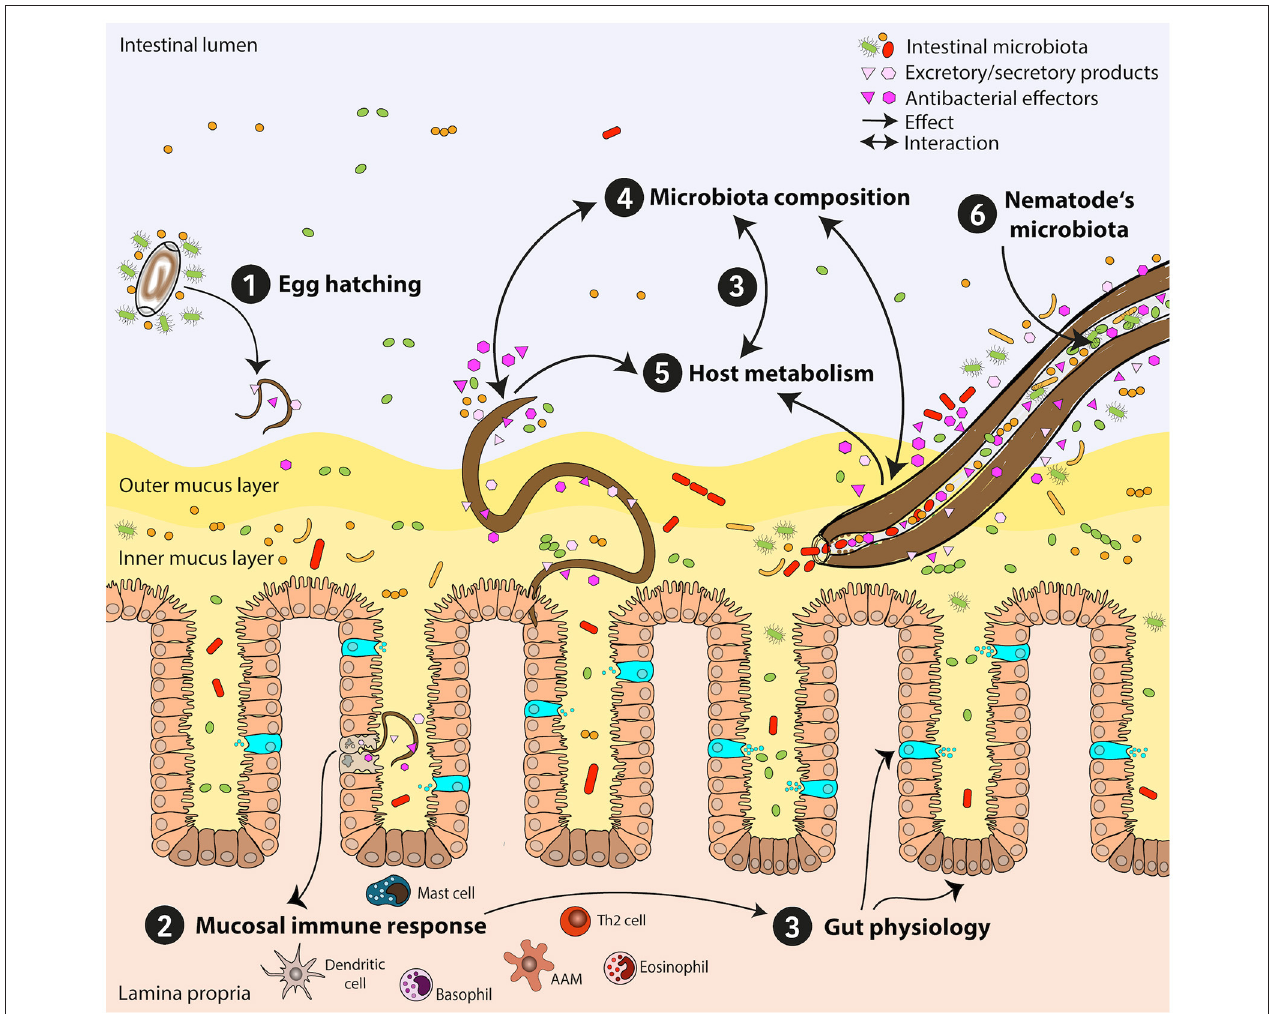
FIGURE 2 | Mutual influences of intestinal nematodes and host-gut bacteria. Establishment and persistence of intestinal nematodes in the host’s gut are affected by bacterial communities and lead to substantial changes of the gut microbiota. Here, nematode-microbiota interactions and their impact on the host immune response and physiology are exemplified. (1) Egg hatching: Interaction of eggs with the intestinal microbiota is needed for some species, enabling larvae to hatch. (2) Mucosal immune response: Attachment to the epithelium and tissue migratory phase might lead to bacterial translocation and manipulation of immune responses. The anti-helminth immune response is predominantly a T helper type 2 response. (3) Gut physiology: Immune responses induce changes in gut physiology via induction of goblet cell hyperplasia, mucus production, and epithelial turnover, leading to changes in the host microbiota and its metabolome. Specific subsets of bacteria directly influence host physiology through their metabolic activities (e.g., short chain fatty acids-producing bacteria). (4) Microbiota composition: Intestinal nematodes modify intestinal microbial communities via different mechanisms: a) directly via secretion of antibacterial molecules and/or excretory/secretory products, b) indirectly by metabolic and physiologic shifts influencing the gut milieu. Chronic infections often lead to reduction in bacterial diversity and outgrowth of specific bacterial species beneficial for parasite survival. (5) Host metabolism: Intestinal nematodes modify host metabolism and nutrient uptake, e.g., alter amino acid, fatty acid, and carbohydrate metabolism, with subsequent influence on gut physiology, immune reactivity, and intestinal microbiota composition. (6) Nematode’s microbiota: Nematode-associated bacterial communities might reflect the host microbiota and may also serve as transmission vehicles for pathogenic bacteria. Th2 cell, T helper type 2 cell; AAM, alternatively activated